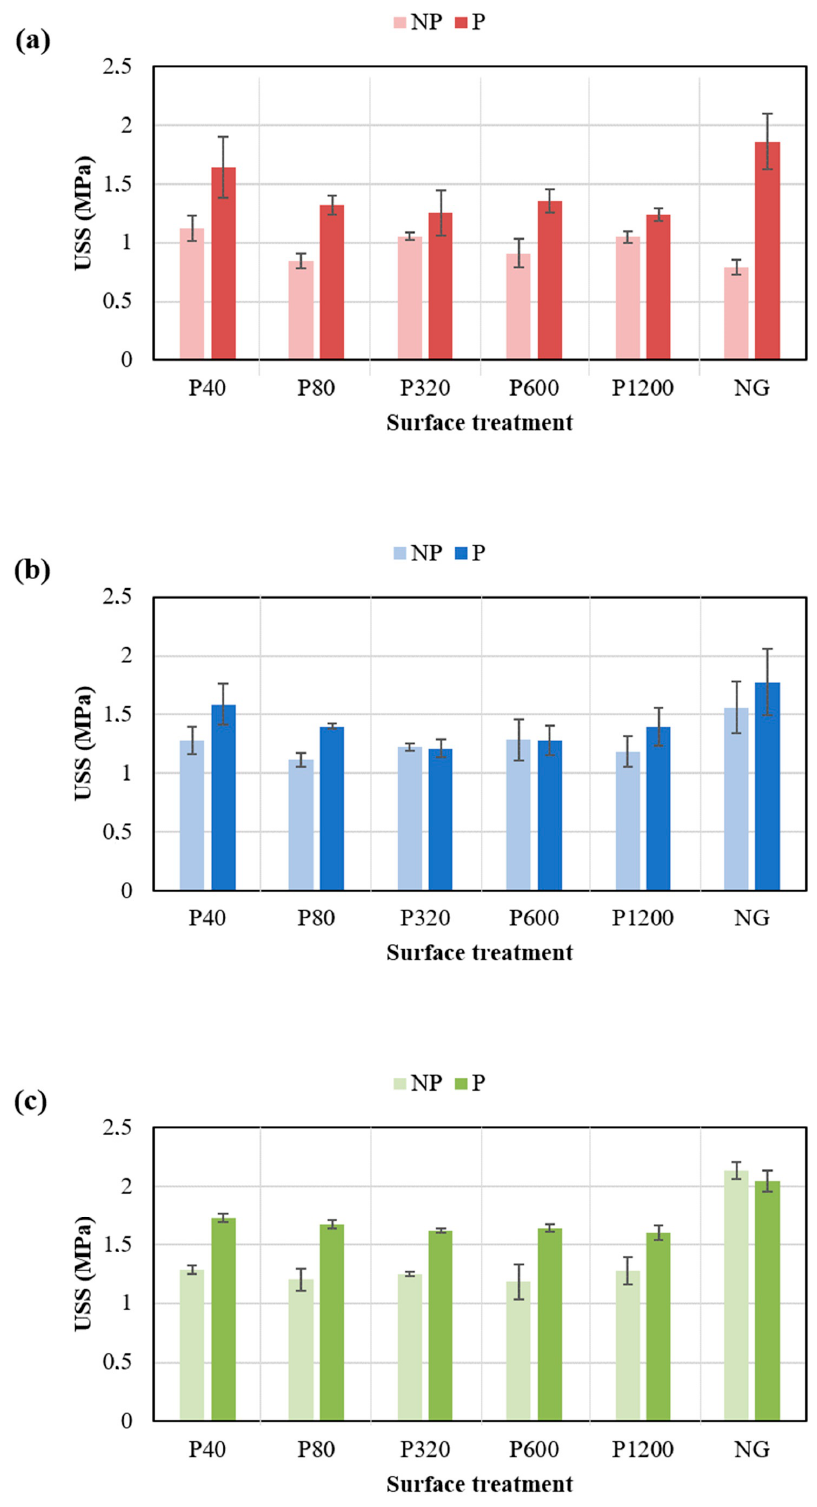
Figure 10. USS values of joints with (P) and without (NP) adhesion promoter for aluminium joints assembled with ( a ) FC, ( b ) RF, and ( c )